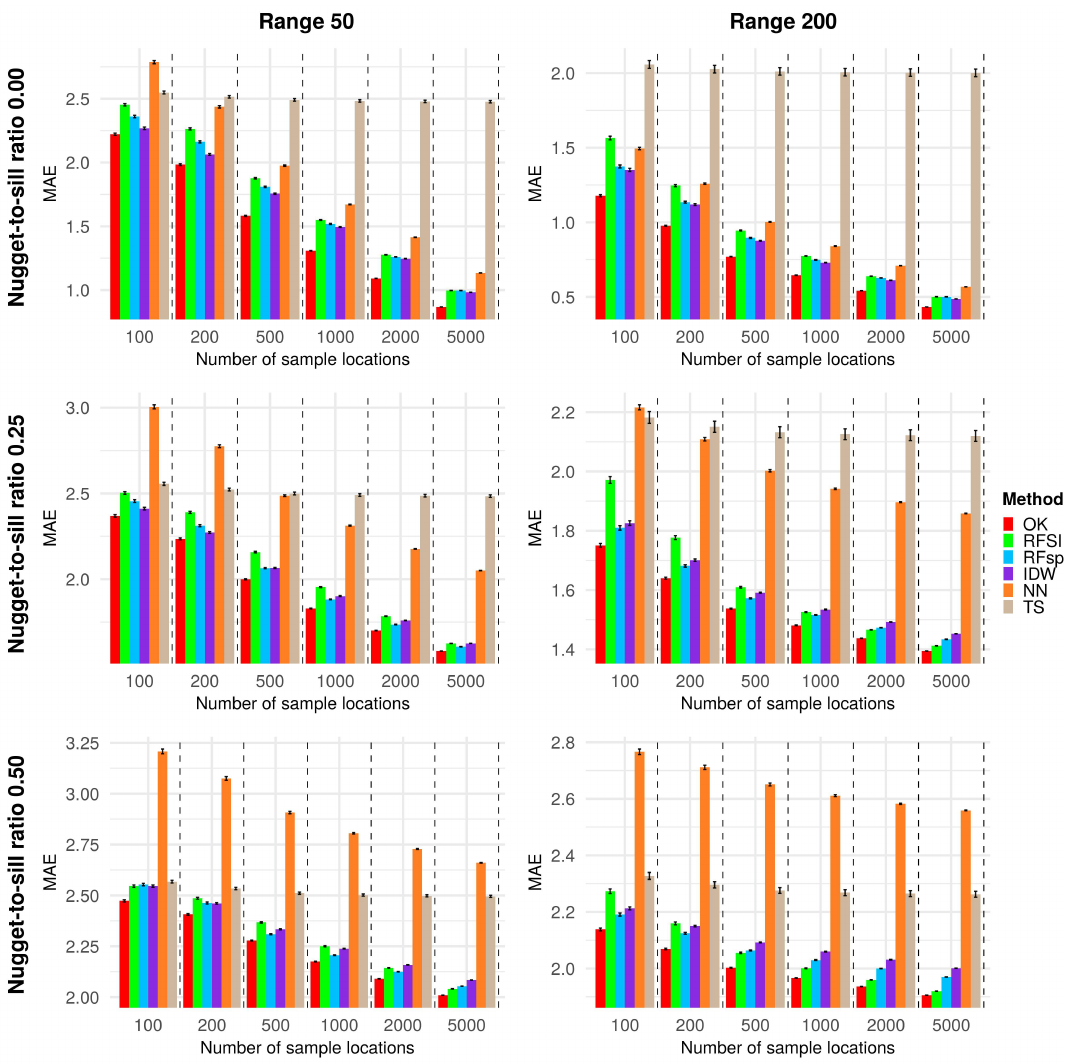
Figure 4. Comparison of average MAE estimated for each of the interpolation methods, for all nugget-to-sill ratios and ranges. Coloured bars are average MAE for test locations from 100 different simulations. Error bars are standard errors computed from 100